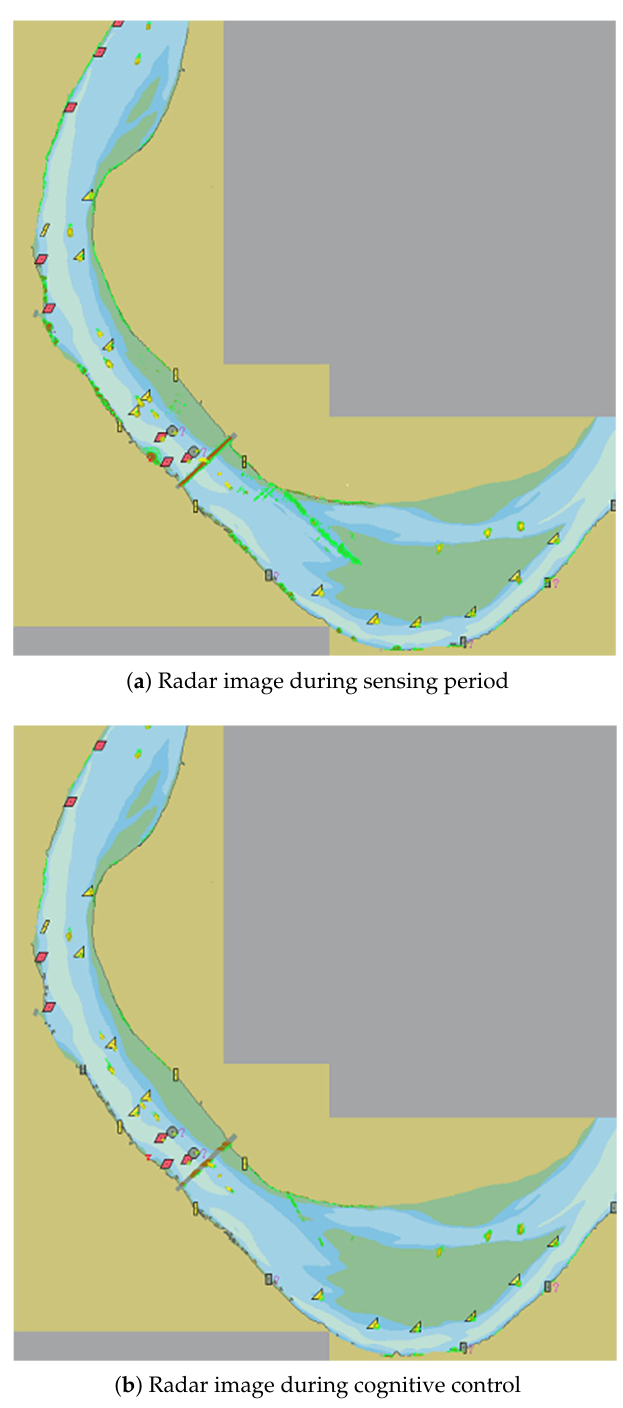
Figure 8. Comparison of radar images during perception and cognitive